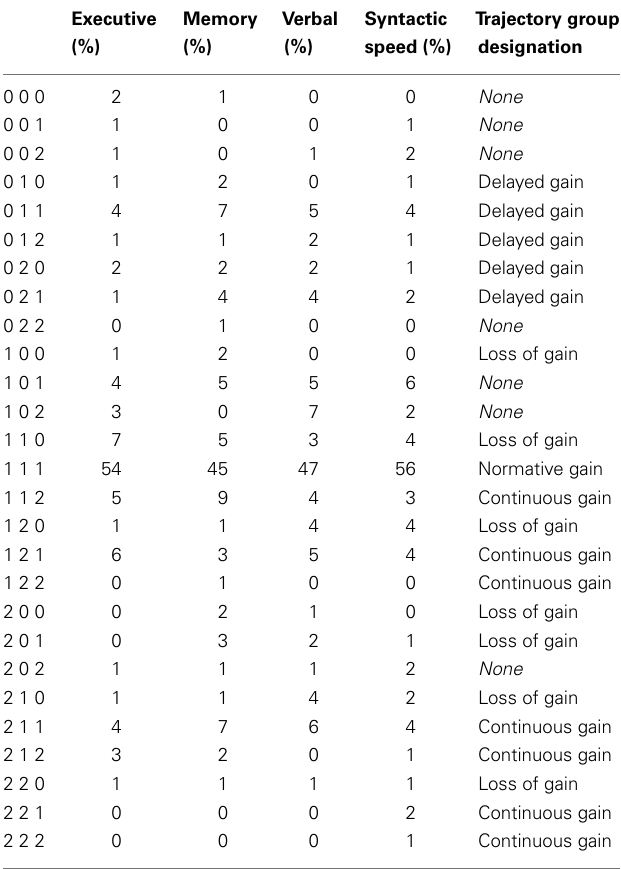
Table 2 | Changes in latent factor scores categorized by deviation from group